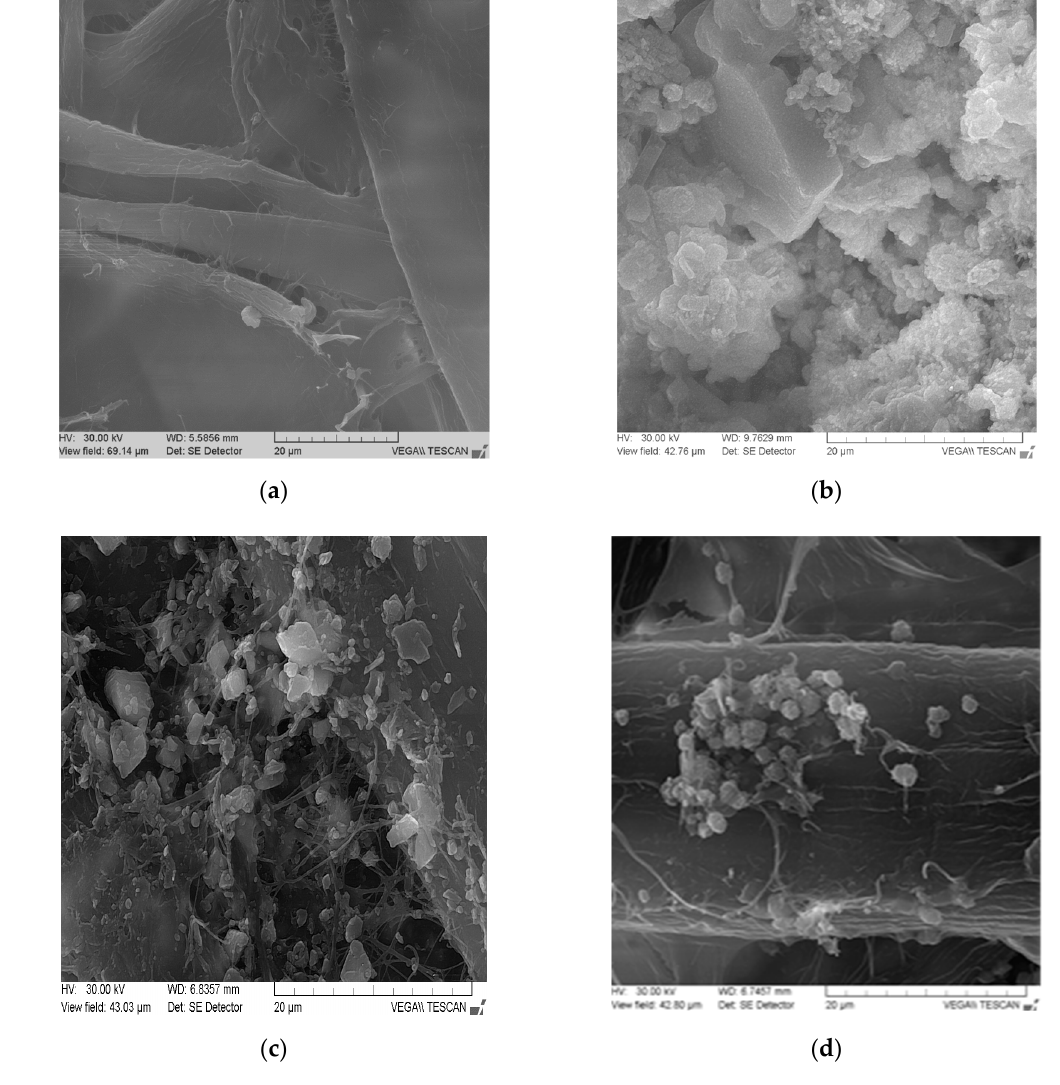
Figure 2. SEM images of paper samples, obtained by conventional and respectively, in-situ loading with precipitated calcium carbonate. ( a ) Without loading. ( b ) CaCO 3 obtained from CaCl 2 /Na 2 CO 3 . ( c ) In-situ loading. ( d ) Conventional loading.